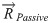
Experimental rigid body falling pattern (discretized lines) and force obtained from the mathematical model of R→Passive (continuous line) pattern.The vertical and horizontal force components, in both cases, are represented. For clarity of representation the horizontal component has been multiplied by -1.